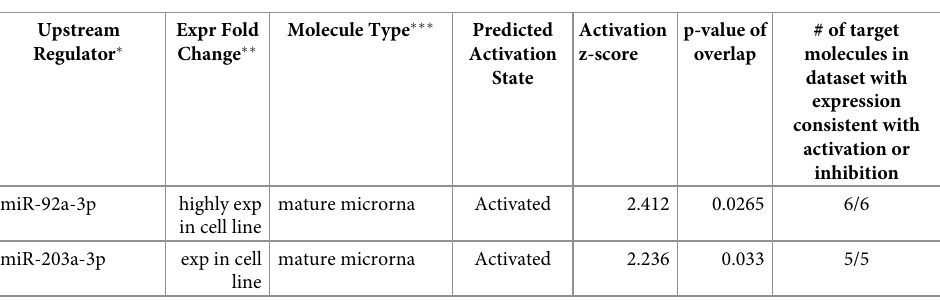
� Bolded font denotes genes with fold change in expression with p value and FDR < 0.05, regular font denotes fold change in expression with p < 0.05